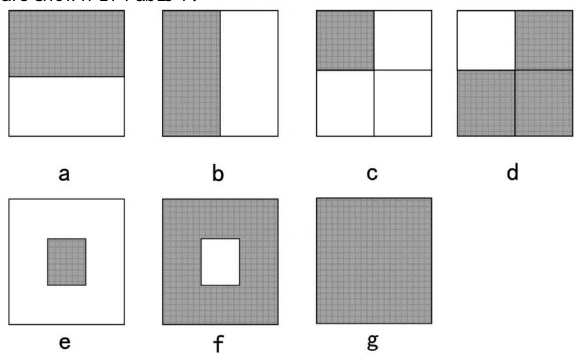
Figure 2. Seven situations of GCP and CP distribution.